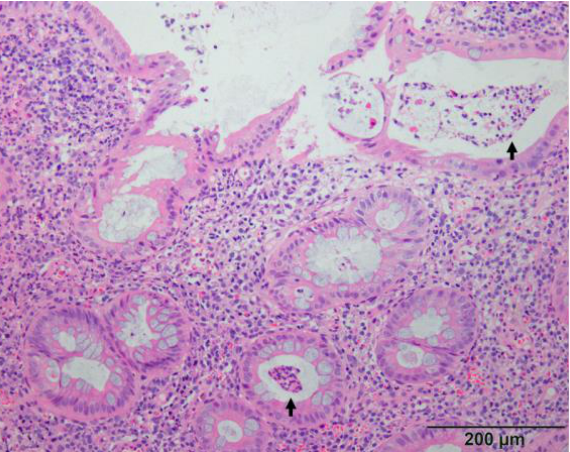
Figure 3. Photomicrograph of the biopsy specimen from the sigmoid colon. Crypt abscess (arrows), goblet cell depletion, and mononuclear cell infiltration were observed.